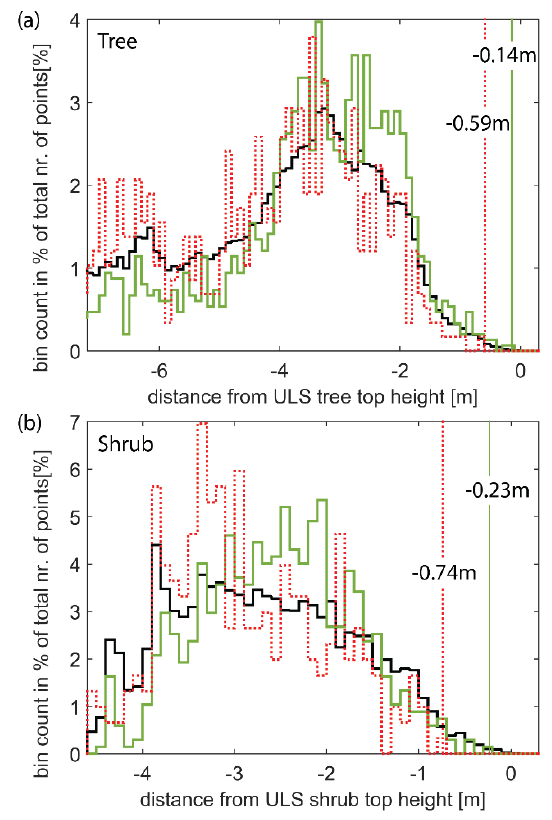
Figure 4. Estimation of tree (a) and (b) shrub heights based on histogram of 3d points within vegetation column; the reference zero height is estimated from ULS data; black: ULS; green: ALB; red: ALS.